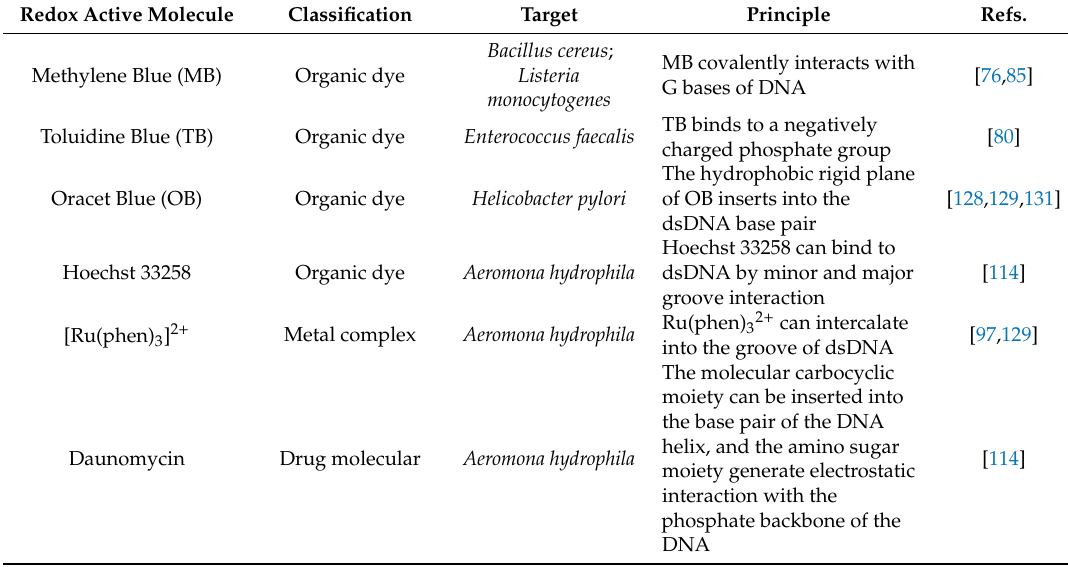
Table 5. Redox active molecules applied in electrochemical DNA biosensors Redox Active